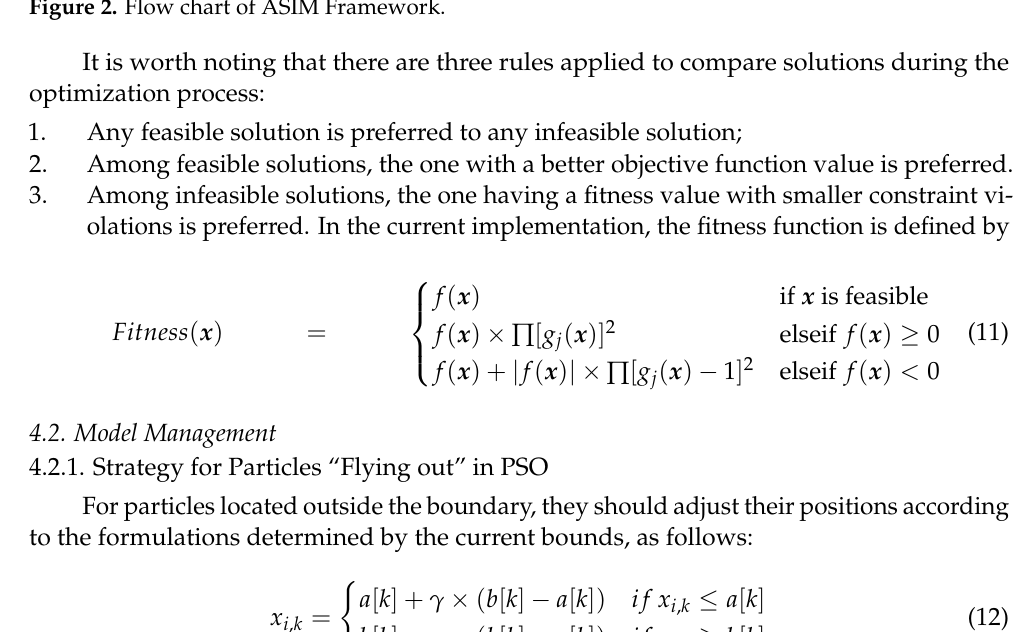
Figure 2. Flow chart of ASIM